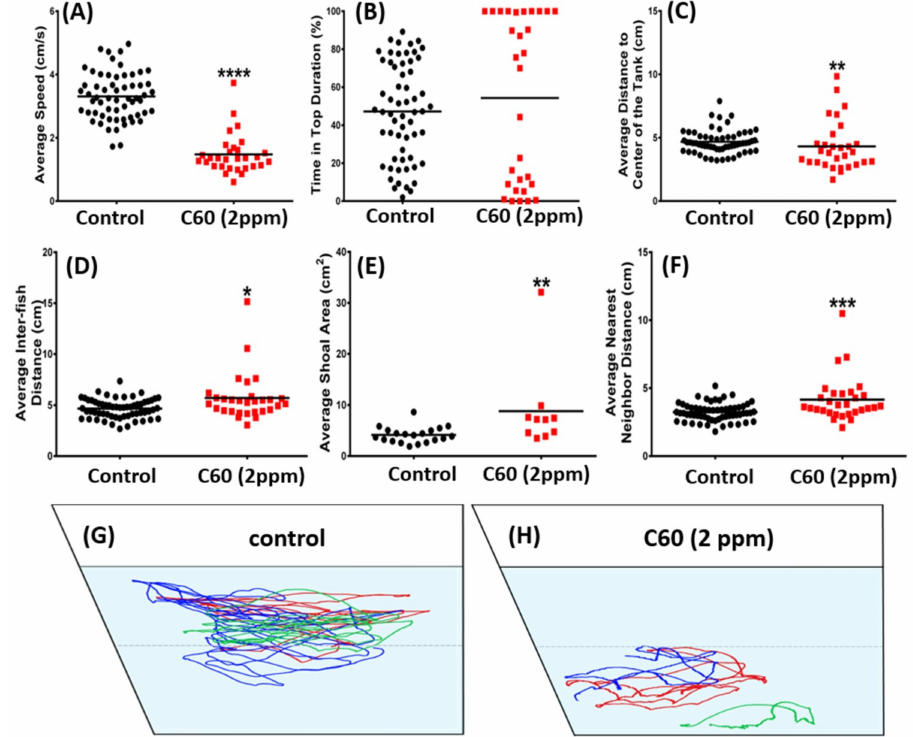
Figure 8. Comparison of shoaling behavior endpoints between wild-type and C 60 NPs-exposed zebrafish after nine-day exposure. ( A ) Average speed, ( B ) time in top duration, ( C ) average distance to center of the tank, ( D ) average inter-fish distance, ( E ) average shoal area, and ( F ) average nearest neighbor distance were analyzed. The swimming trajectories of the control ( G ) and C 60 NPs-exposed fish ( H ) for shoaling test were recorded and compared. Three fish were tested for shoaling behavior and their trajectories were labeled by different color for clarifying their identity. The data are expressed as the means and were analyzed by Mann–Whitney test ( n = 60 for control; n = 30 for C 60 NPs-exposed fish; * p < 0.05, ** p < 0.01, *** p < 0.005, ****, p <